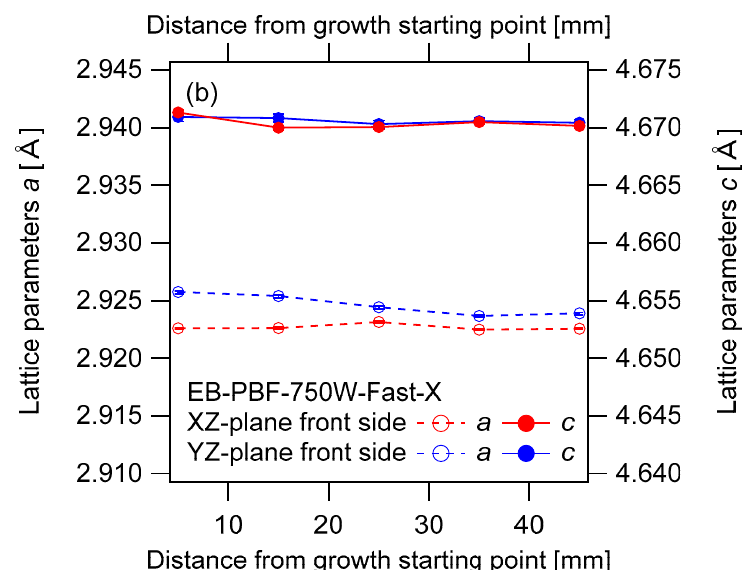
Figure 10. α or α ’ phase lattice parameters measured at different locations on ( a ) EB-PBF-900W-Slow-X and ( b ) EB-PBF-750W-Fast-X. The data points on the front sides, colored red and blue in Figure 1, are shown. The a -axis was long at the beginning of the growth process and then became shorter as the parts grew in the Z direction. This trend is more significant on the YZ plane than on the XZ plane.